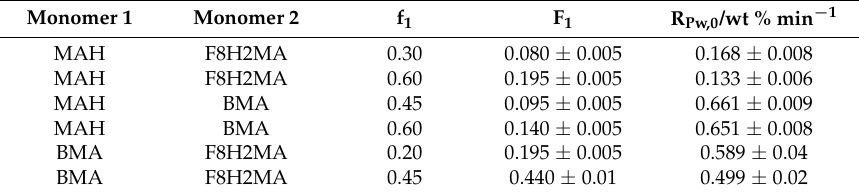
MAH, maleic anhydride; BMA, n -butyl methacrylate; F8H2MA, 1 H ,1 H ,2 H ,2 H -perfluorodecyl methacrylate; R Pw,0 , initial weight rates of polymerization .